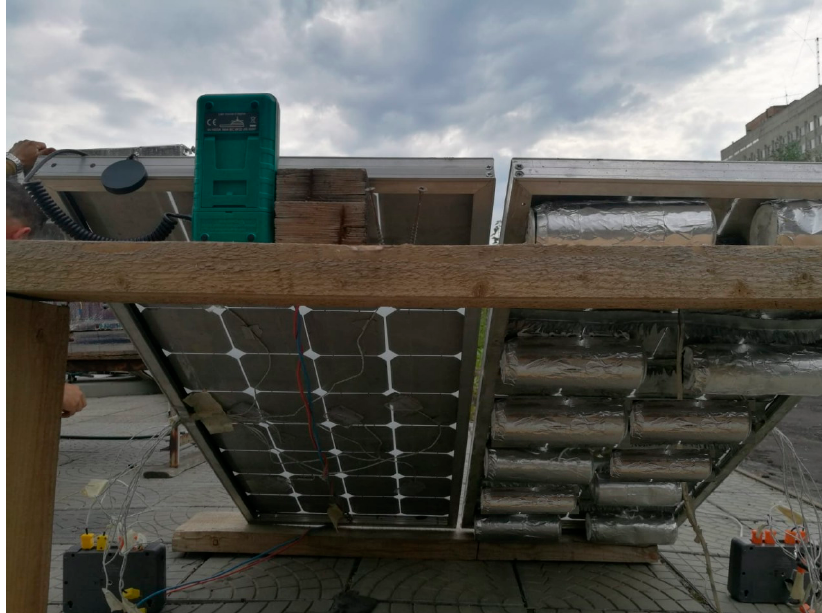
Figure 2. Rear side of the PV panels: referenced (left) cooled (right).